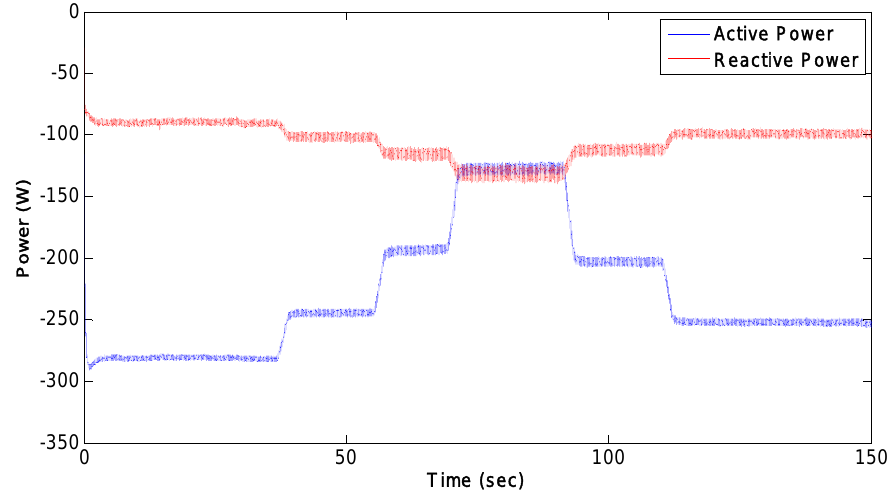
Figure 12. Power response by varying the rotor q -current.